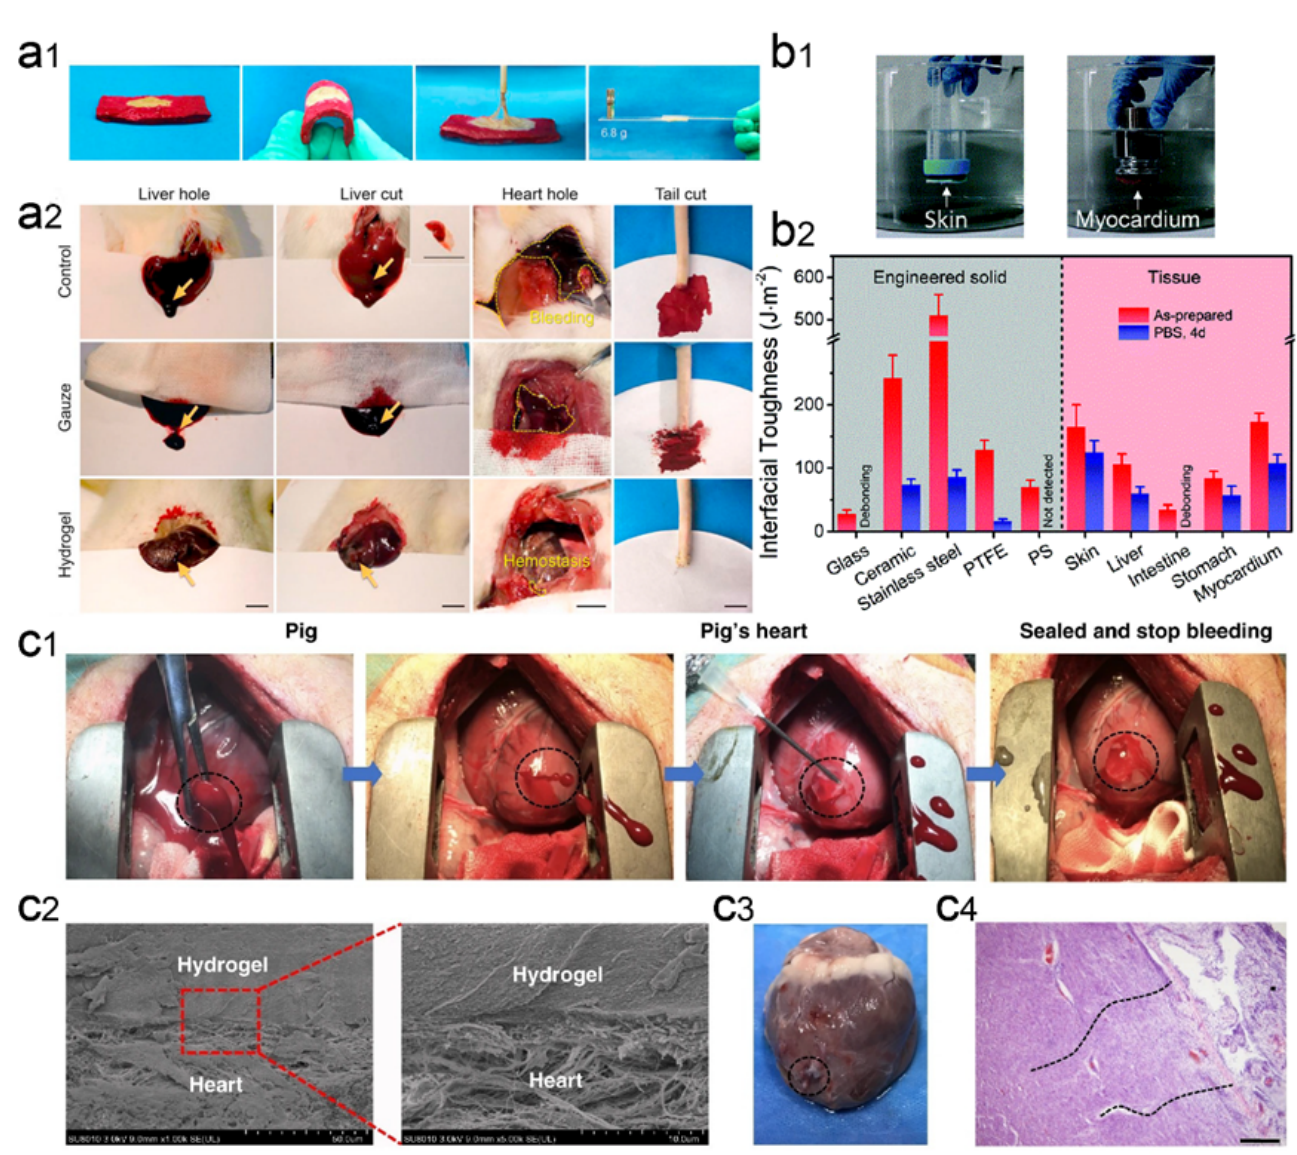
Figure 7. Wet-adhesive hemostatic hydrogel in heart wounds. ( a ) Adhesion and hemostatic proper-ties of CS/TA/SF hydrogels. Figure modified from [96] with permission. ( a1 ) The photos show that the hydrogel has strong adhesion to wet pigskin and glass. ( a2 ) Hemostatic images of various untreated wounds covered with gauze or hydrogel. ( b ) Strong adhesion properties of PCT hydrogels. Figure modified from [97] with permission. ( b1 ) Optical image of direct adhesion of PCT hydrogel between high-density polyethylene substrate and porcine skin or myocardium in PBS environment. ( b2 ) Interfacial toughness of PCT hydrogels with different substrate surfaces before and after 4 days of immersion in PBS. ( c ) GelMA/HA-NB hydrogel adhesion and hemostatic properties. Figure modified from [98] with permission. ( c1 ) Optical image of rapid hemostatic closure after a heart puncture wound. Blood exudation completely stopped within 10 seconds. ( c2 ) Scanning electron micrographs of the interface between a porcine heart puncture wound and hydrogel. ( c3 ) Autopsy images of the heart were performed after two weeks of postoperative recovery. ( c4 ) Tissue-stained image of the interface between the heart tissue and the matrix gel of a pig heart 2 weeks after postoperative